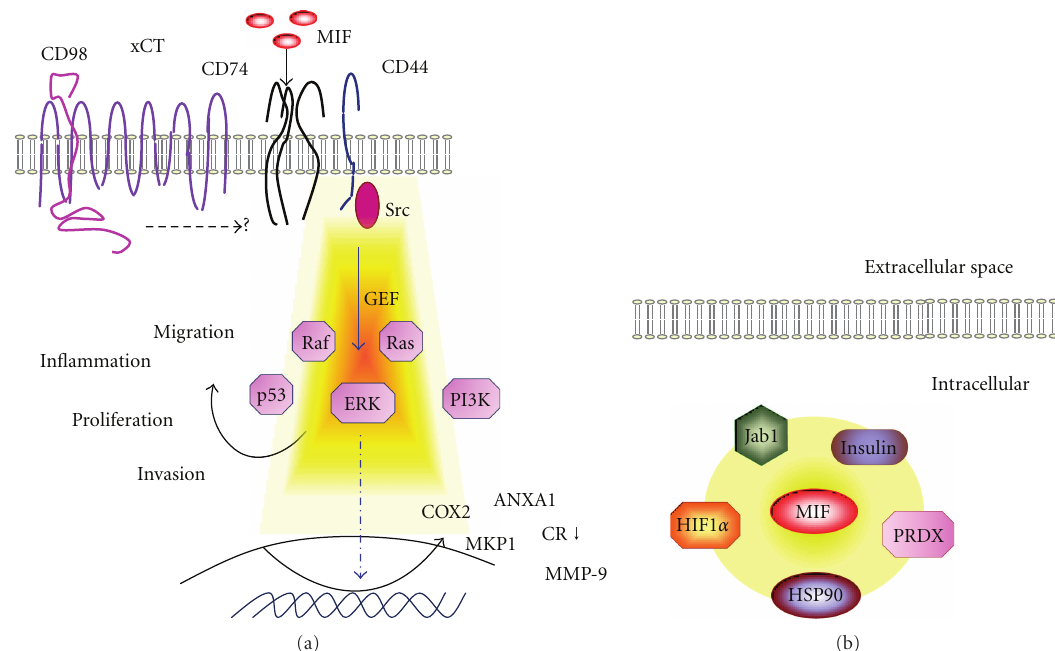
Figure 4: MIF receptor signalling and downstream e ff ectors. (a) Schematic model of receptor-mediated MIF signalling involving CD74 and , xCT forms a heterodimer with CD98 as indicated) in CD74/CD44- CXCRs. The involvement of the glutamate antiporter xCT (system x − c dependent signalling is proposed, indicated by the dotted arrow. (b) MIF binding partners with link to brain cancer. Note that the indicated MIF-binding partners given in the scheme are far from complete. Abbreviations used: COX2, cyclooxygenase 2; ERK, extracellular signal-regulated kinases; GC, glucocorticoids; GR, glucocorticoid receptor; GEF, guanosine exchange factor; HIF1 α , hypoxy Jab1,